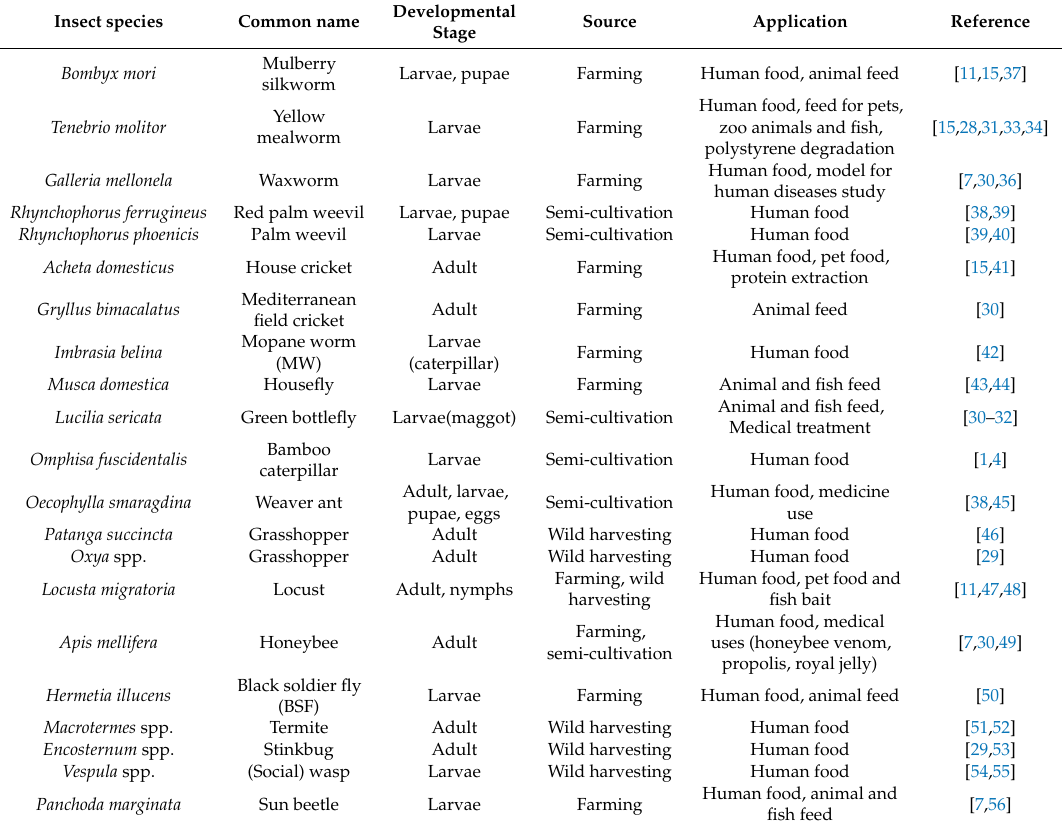
Table 1. Summary of the edible insect species most commonly reared for food and feed, the developmental stage at which they are used, the type of farming system, and commercial